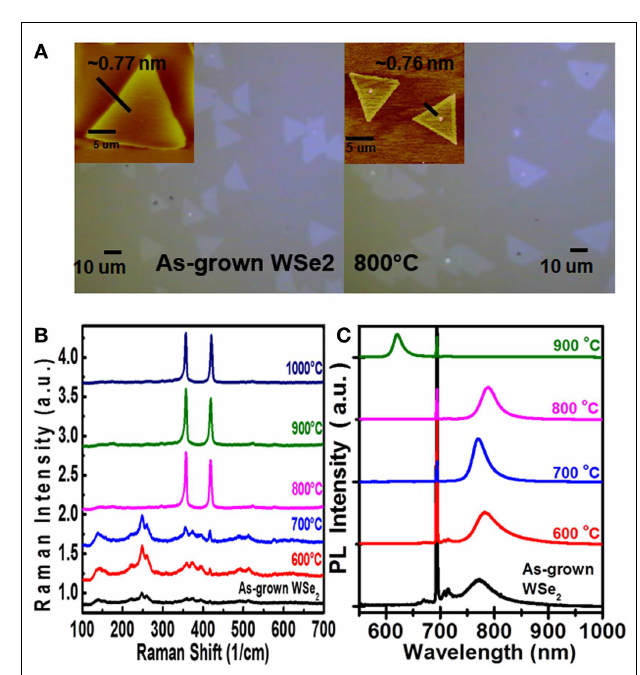
FIGURE 8 | (A) OM and AFM images, (B) Raman spectra, and (C) PL spectra of theWSe 2 flakes after sulfurization at various temperatures.